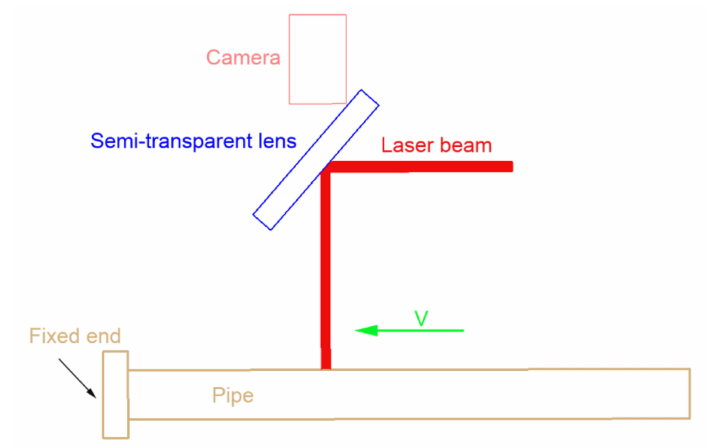
Figure 10. The schematic of laser bending